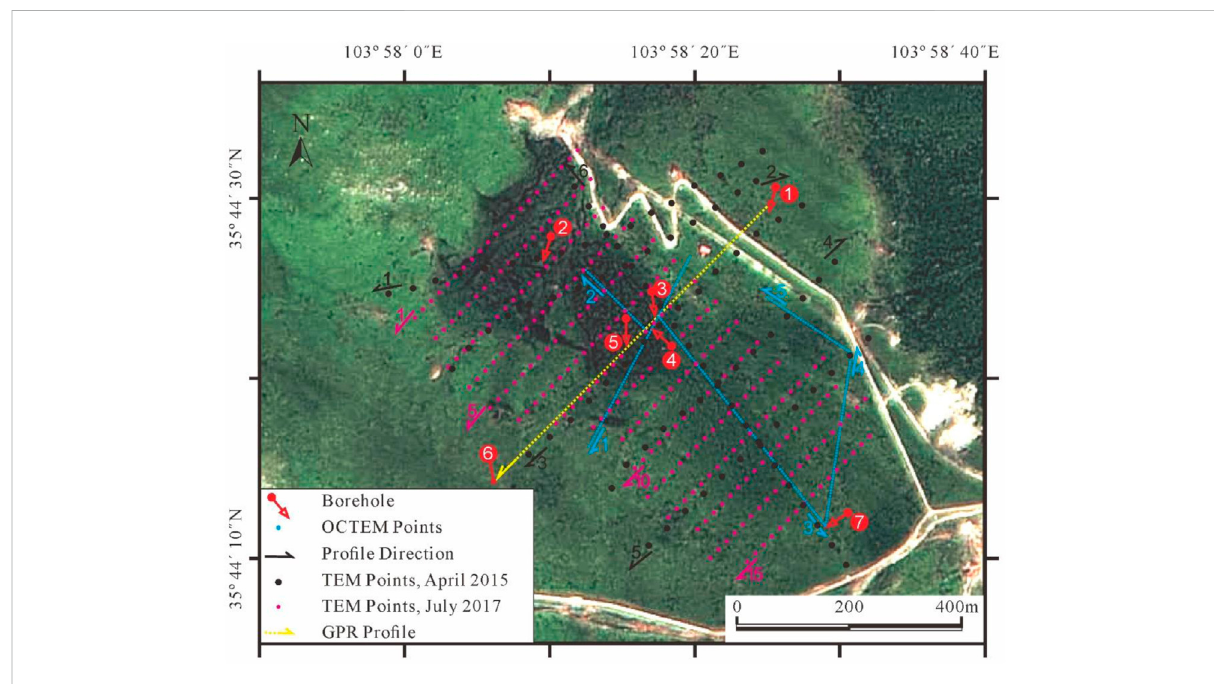
FIGURE 3 Satellite map of the Mahan Mountain permafrost region and geophysical exploration work